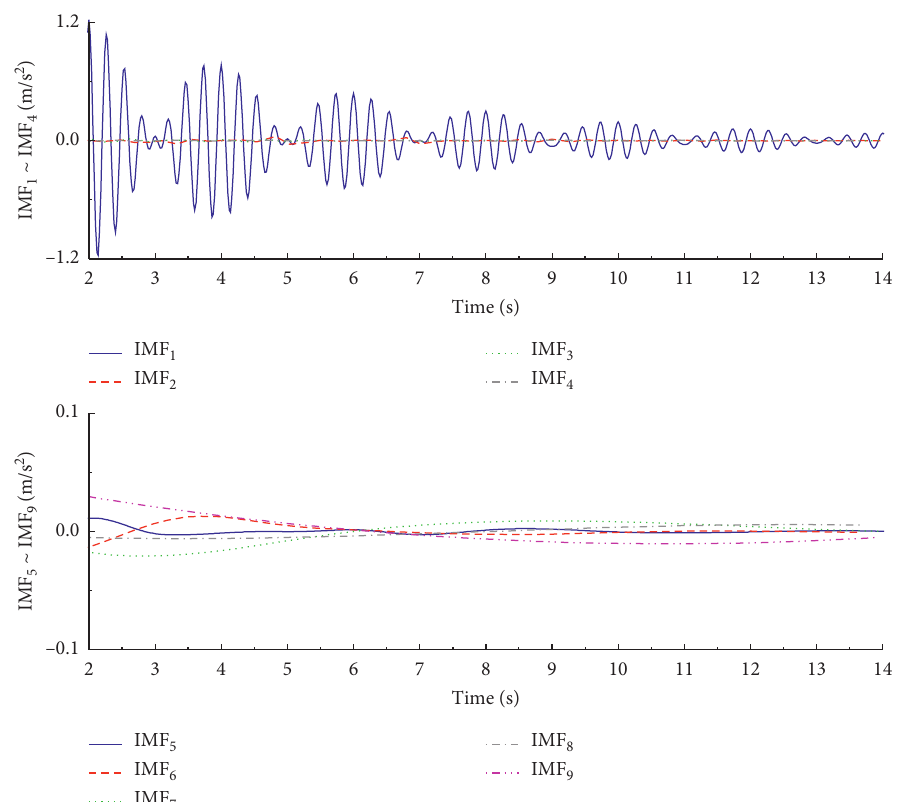
Figure 2: Modal responses of 2 degree-of-dreedom (DOF) system (Hilbert vibration decomposition (HVD) results). v maximum amplitude components under the instantaneous frequency of f 1 � 3.5Hz and f 2 � 4Hz.